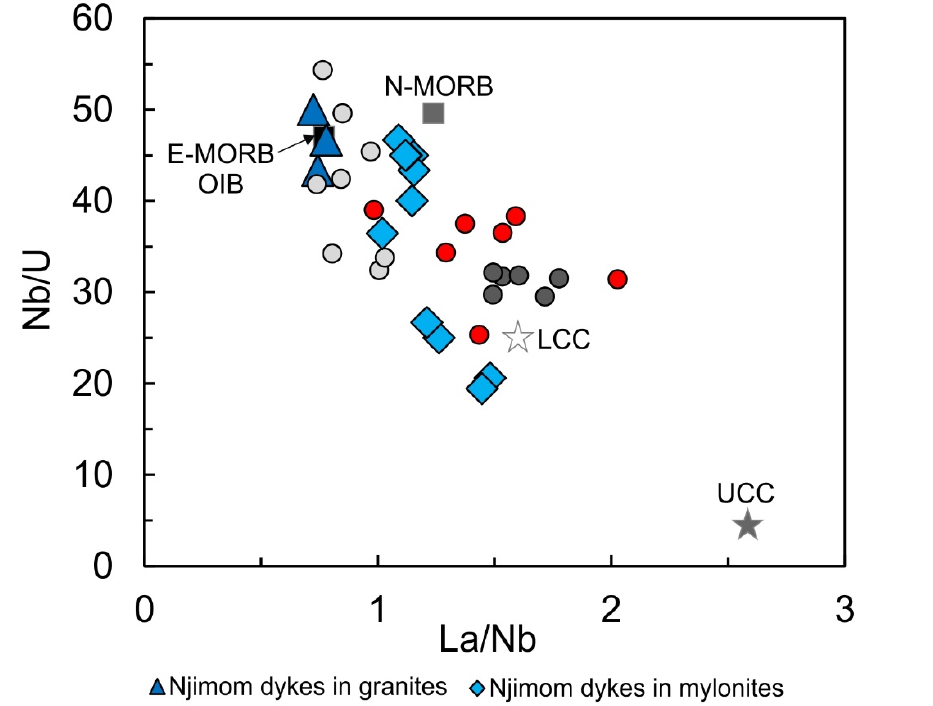
Figure 12. La/Nb vs Nb/U for the Njimom dykes. Data for upper continental crust (UCC) and lower continental (LCC) (star symbols) are from [27]. Data for oceanic basalts (OIB) and MORBs are from [25,28]. Data from Manjo [6]; Kekem [5]; Bangoua, Maham, Dschang, and Kendem [7] are shown for comparison.